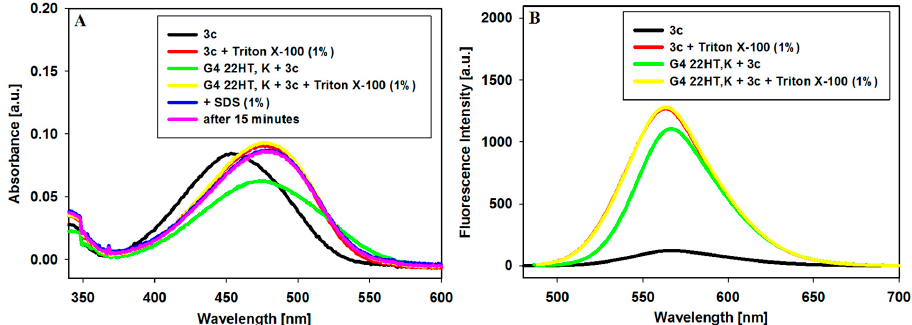
Figure 2. The effect of Triton X-100 on dissociation the ligand 3c (3 µM) from the DNA complex in potassium-based buffer. ( A ) Absorption spectra and ( B ) fluorescence spectra; conditions: [L] = 3 µM, [22HT G4] = 3 µM, 10 mM Tris-HCl buffer (pH 7.2) containing 100 mM KCl; λ ex : 453 and 478 nm.